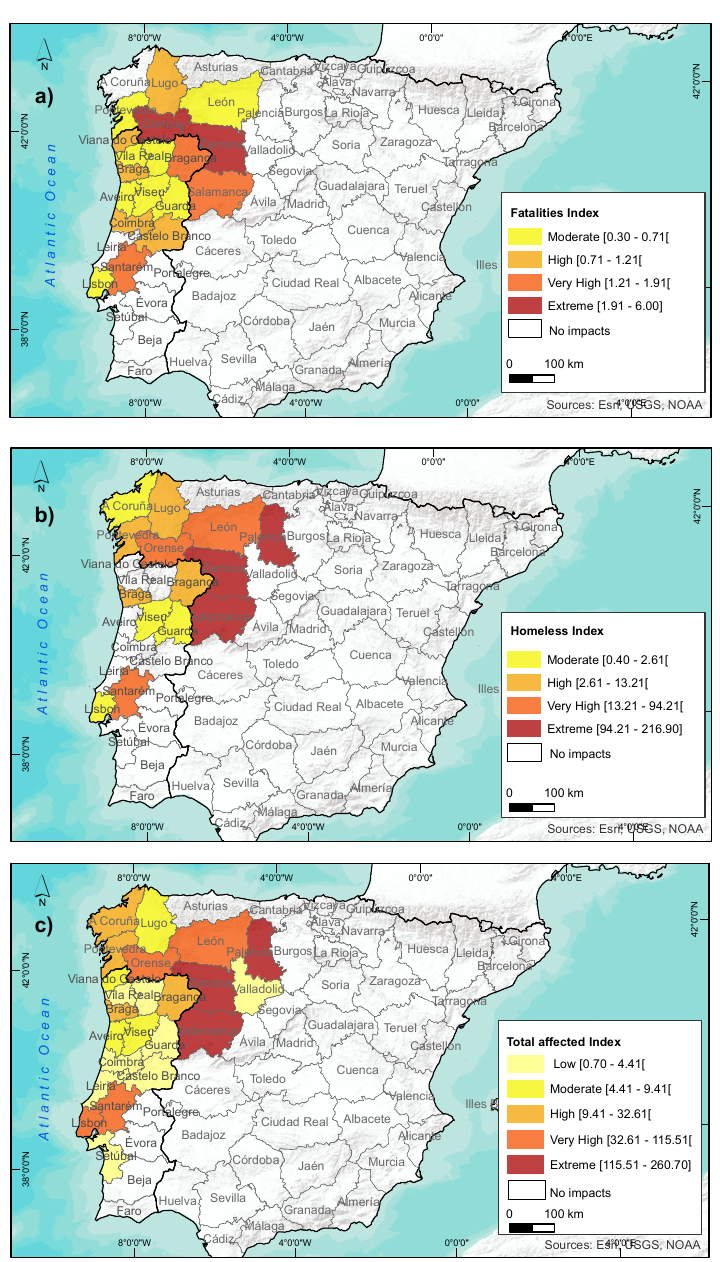
Figure 5. Fatalities index (a) , homeless index (b) , and total affected index (c) of the December 1909 event for affected regions over Iberia.